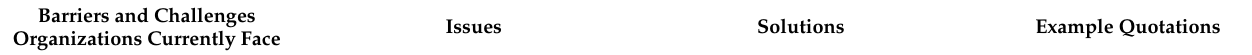
Table 2. Perceived Challenges by Community Stakeholders and ways Morgan CARES